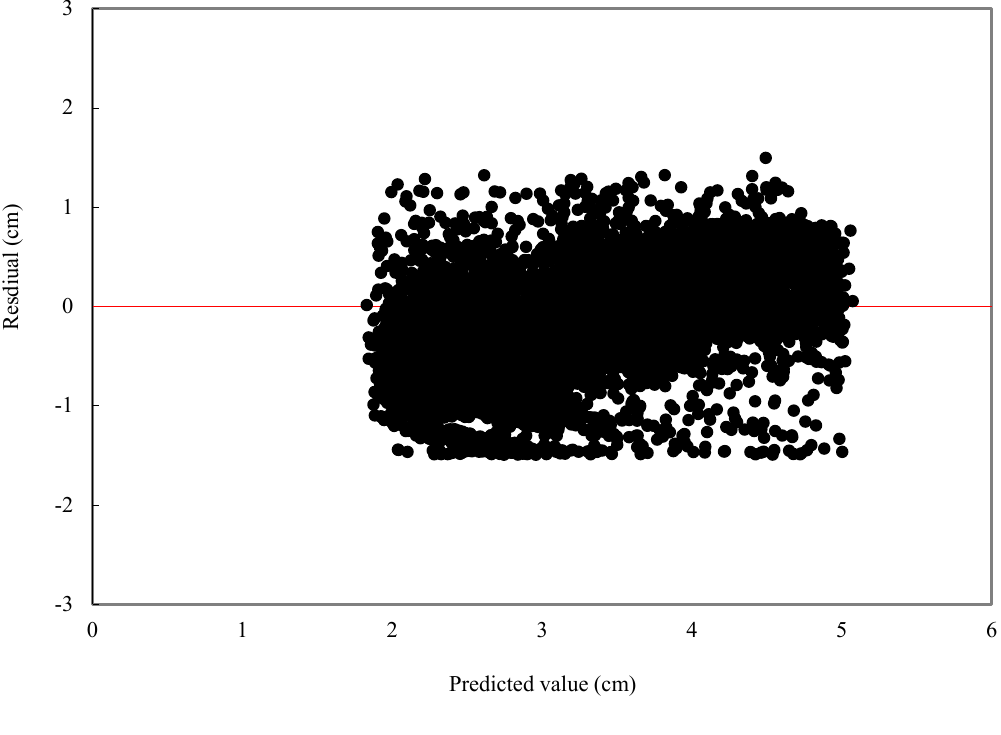
Figure 4. Weighted residuals and predicted values of simultaneous equations for